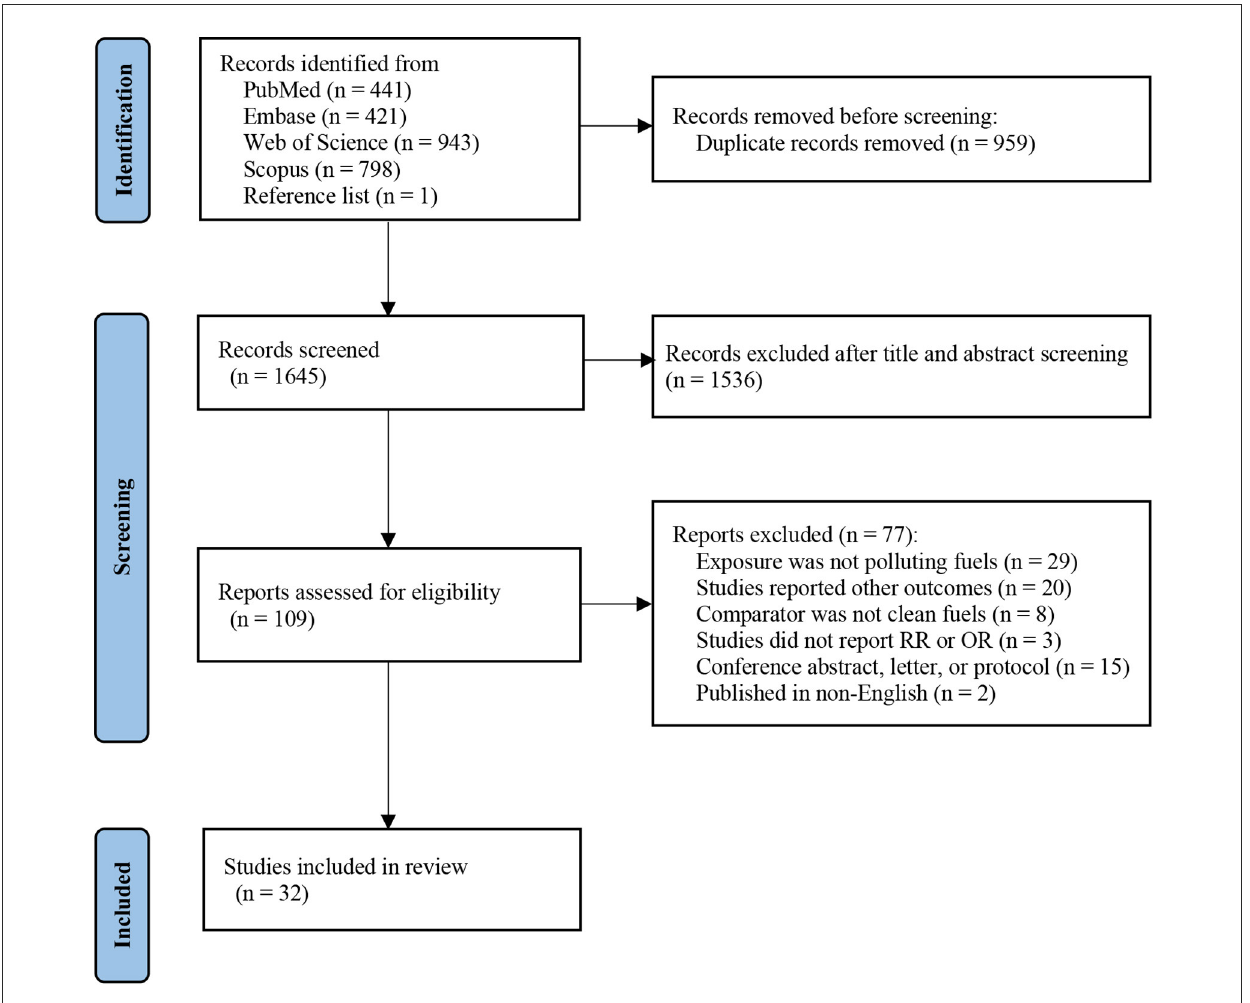
FIGURE1 Flowchart of literature selection.